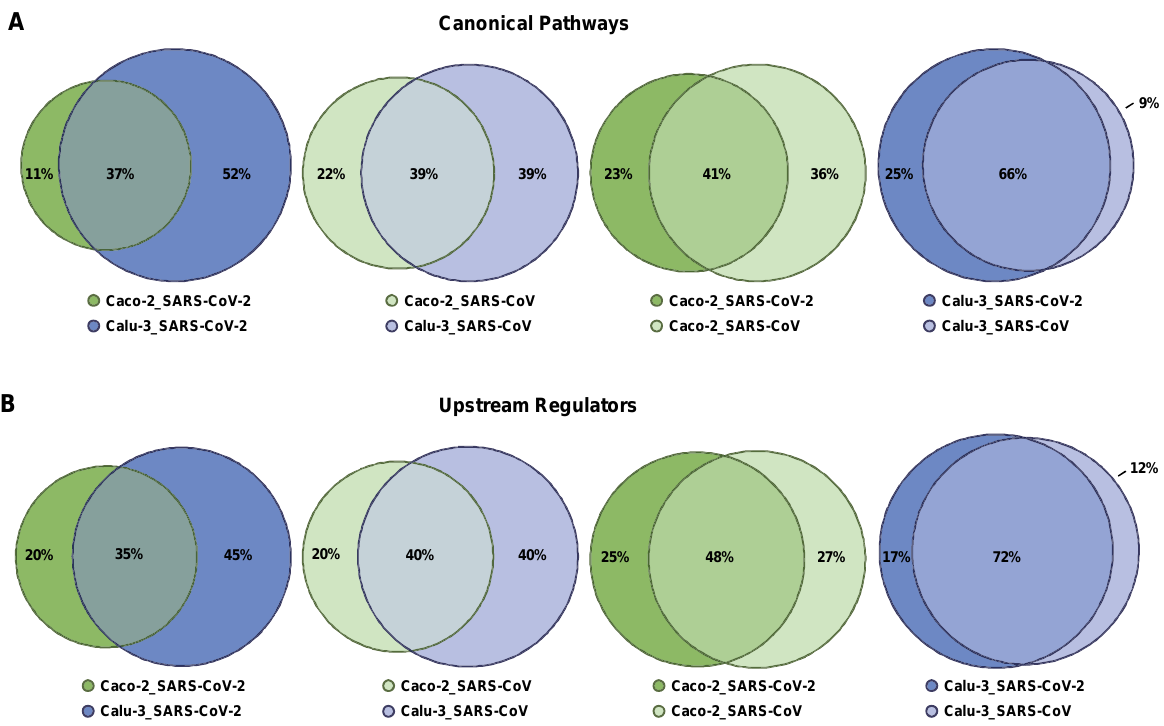
Figure 5. Overlap in Canonical Pathways and Upstream Regulators attributed to Calu-3 cells and Caco-2 cells infected with SARS-CoV-2 and SARS-CoV. R-based comparisons are visualized by scaled Venn diagrams, where circles are sized proportionally. The color code indicates the condition — the cell type (Caco-2 or Calu-3) and the virus type (infection with SARS-CoV-2 or SARS-CoV). Differentially expressed genes for each condition, obtained via GENEVESTIGATOR-based analysis, were taken as the basis for IPA-based Core Analysis to dissect the corresponding Canonical Pathways and Upstream Regulators. Comparison of ( A ) Canonical Pathways and ( B ) Upstream Regulators is shown. The rounding up or rounding off of the values was performed by the R program automatically, according to standard mathematical rules; therefore, the total sum of the three values in a Venn diagram might not be equal to 100.